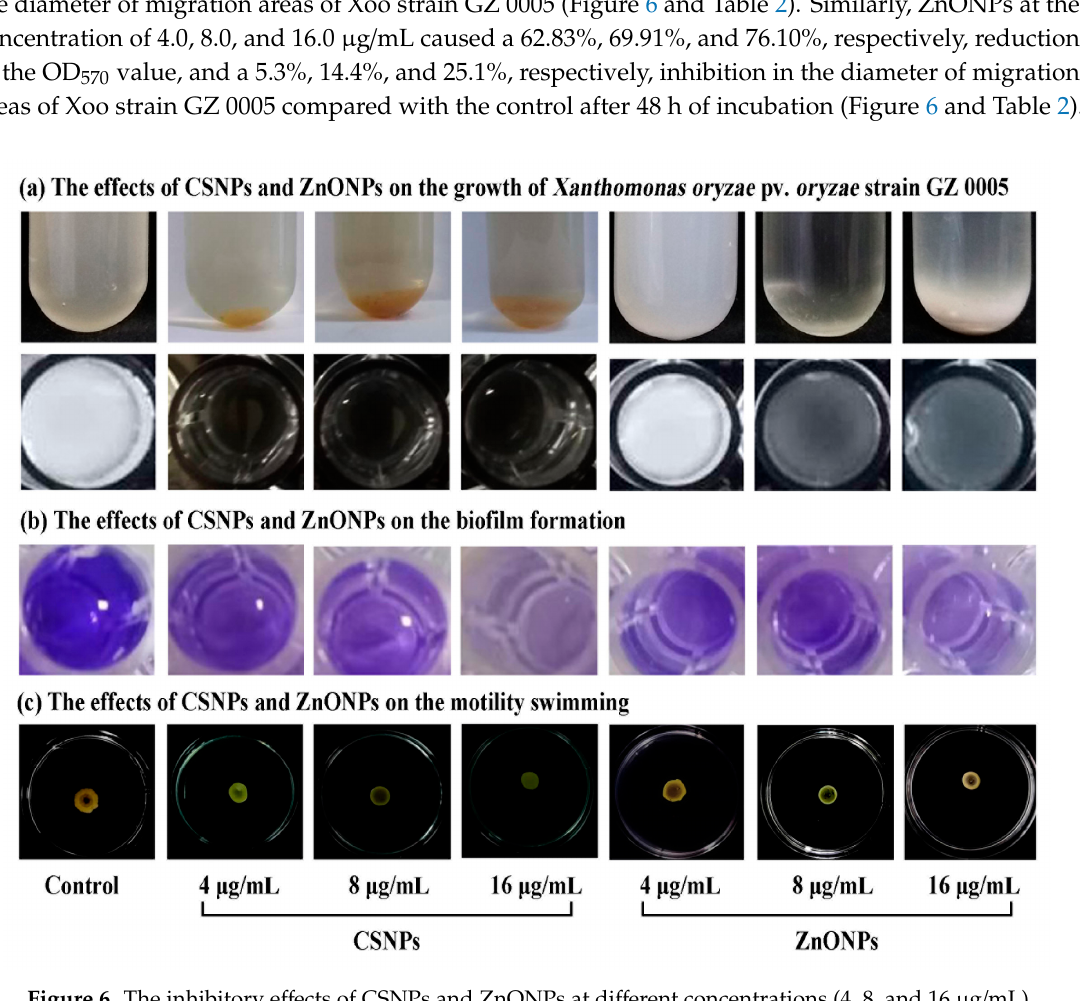
Figure 6. The inhibitory effects of CSNPs and ZnONPs at different concentrations (4, 8, and 16 µg/mL) on ( a ) growth, ( b ) biofilm formation, and ( c ) motility swimming of Xanthomonas oryzae pv. oryzae strain GZ 0005.